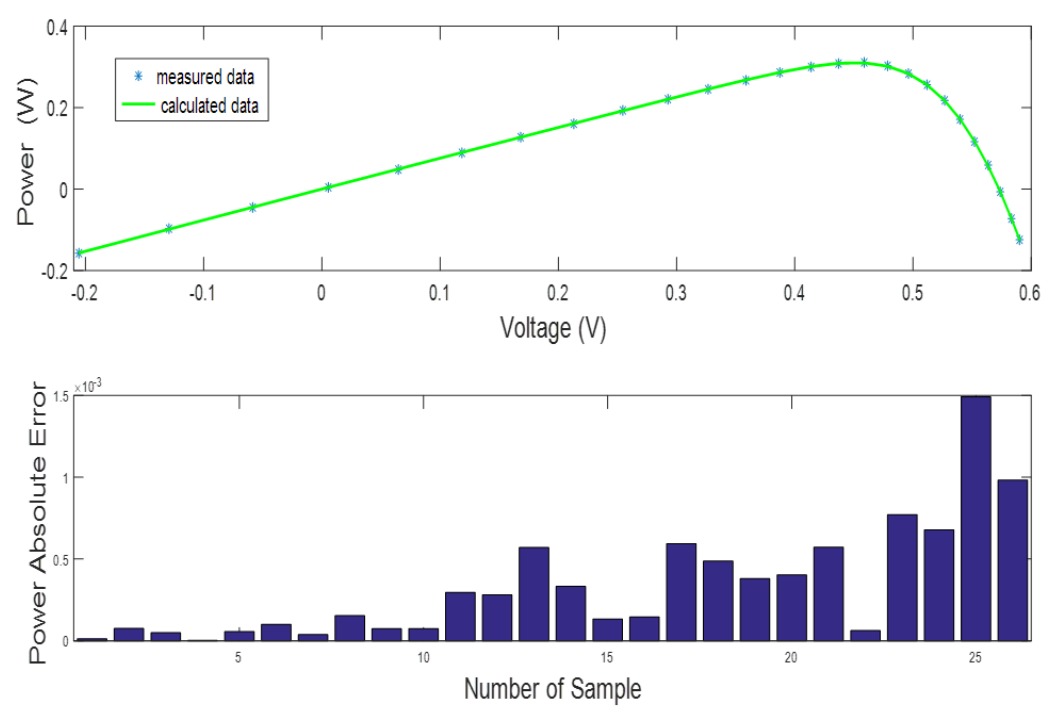
Figure 11. The TDMSC’s I–V curve based on the best solution from the INFO algorithm.